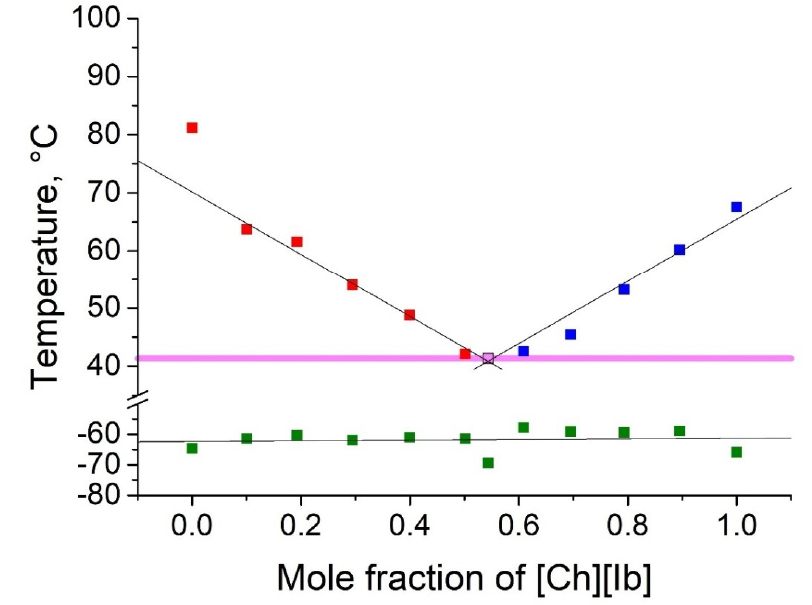
Figure 1. Temperature composition phase diagram for the mixture of choline acetate ([Ch][Ac]) and choline isobutyrate ([Ch][Ib]), and their individual components at 0.0 and 1.0 mole fractions. Legend: (cid:4) —melting point of the excess component [Ch][Ac] in the mixture; (cid:4) —melting point of the excess component [Ch][Ib] in the mixture; (cid:4) —glass transition temperature; (cid:4) —eutectic point; – eutectic transition